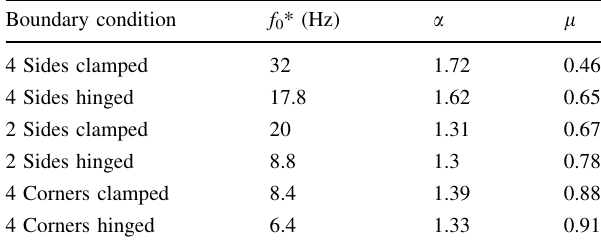
Floor, column and soil modes have been observed in apartment and office buildings. The analysis of differ- ent number of storeys and different stiffnesses of the soil shows the coupling between these modes which leads to lower resonance frequencies and higher resonance amplitudes. These phenomena are in a very good agreement between the simple one-dimensional prediction model and the three-dimensional finite- element model.